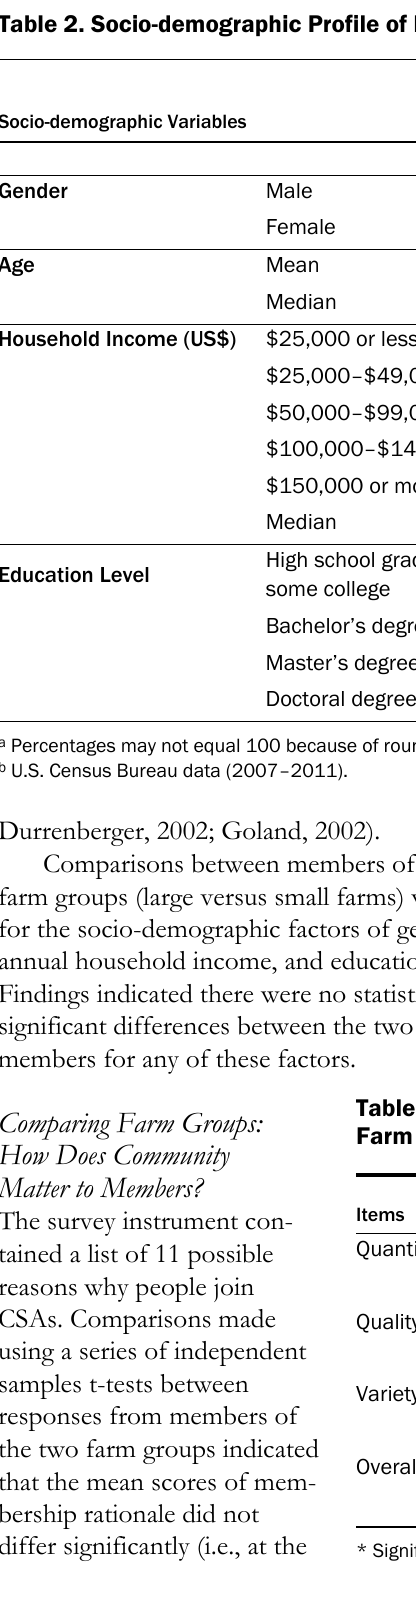
Table 2. Socio-demographic Profile of Respondents